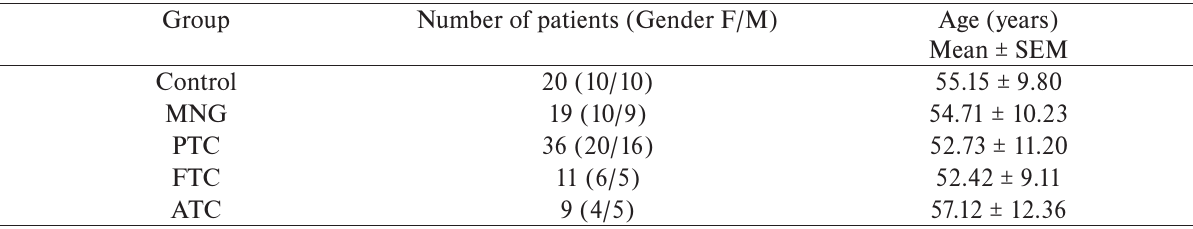
Table 1. Demographic and clinical characterization of the studied